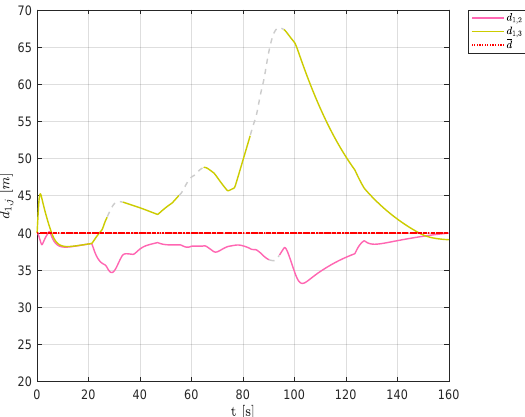
Figure 7. Scenario #1—three aircraft: distances between UAV 1 and the other swarm vehicles. Solid lines are used for visible aircraft, dashed gray lines are employed whenever they are no longer visible. The desired distance is highlighted using a dotted red